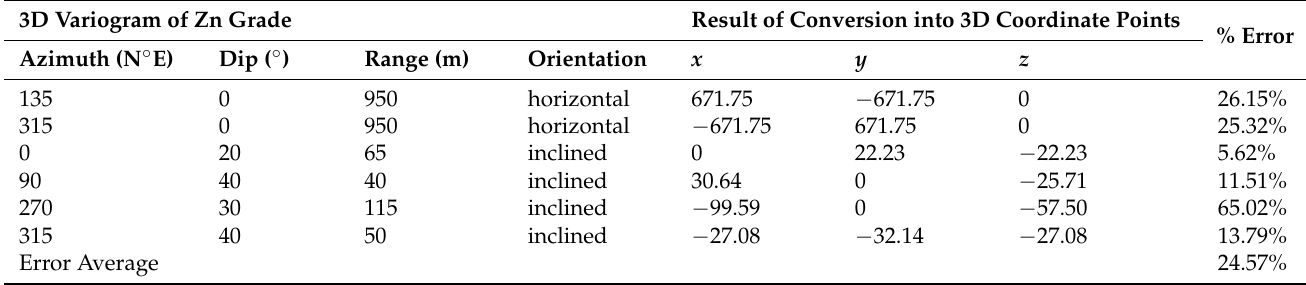
Table 2. Result of error calculation for the 3D fitting model of ellipsoid anisotropy.